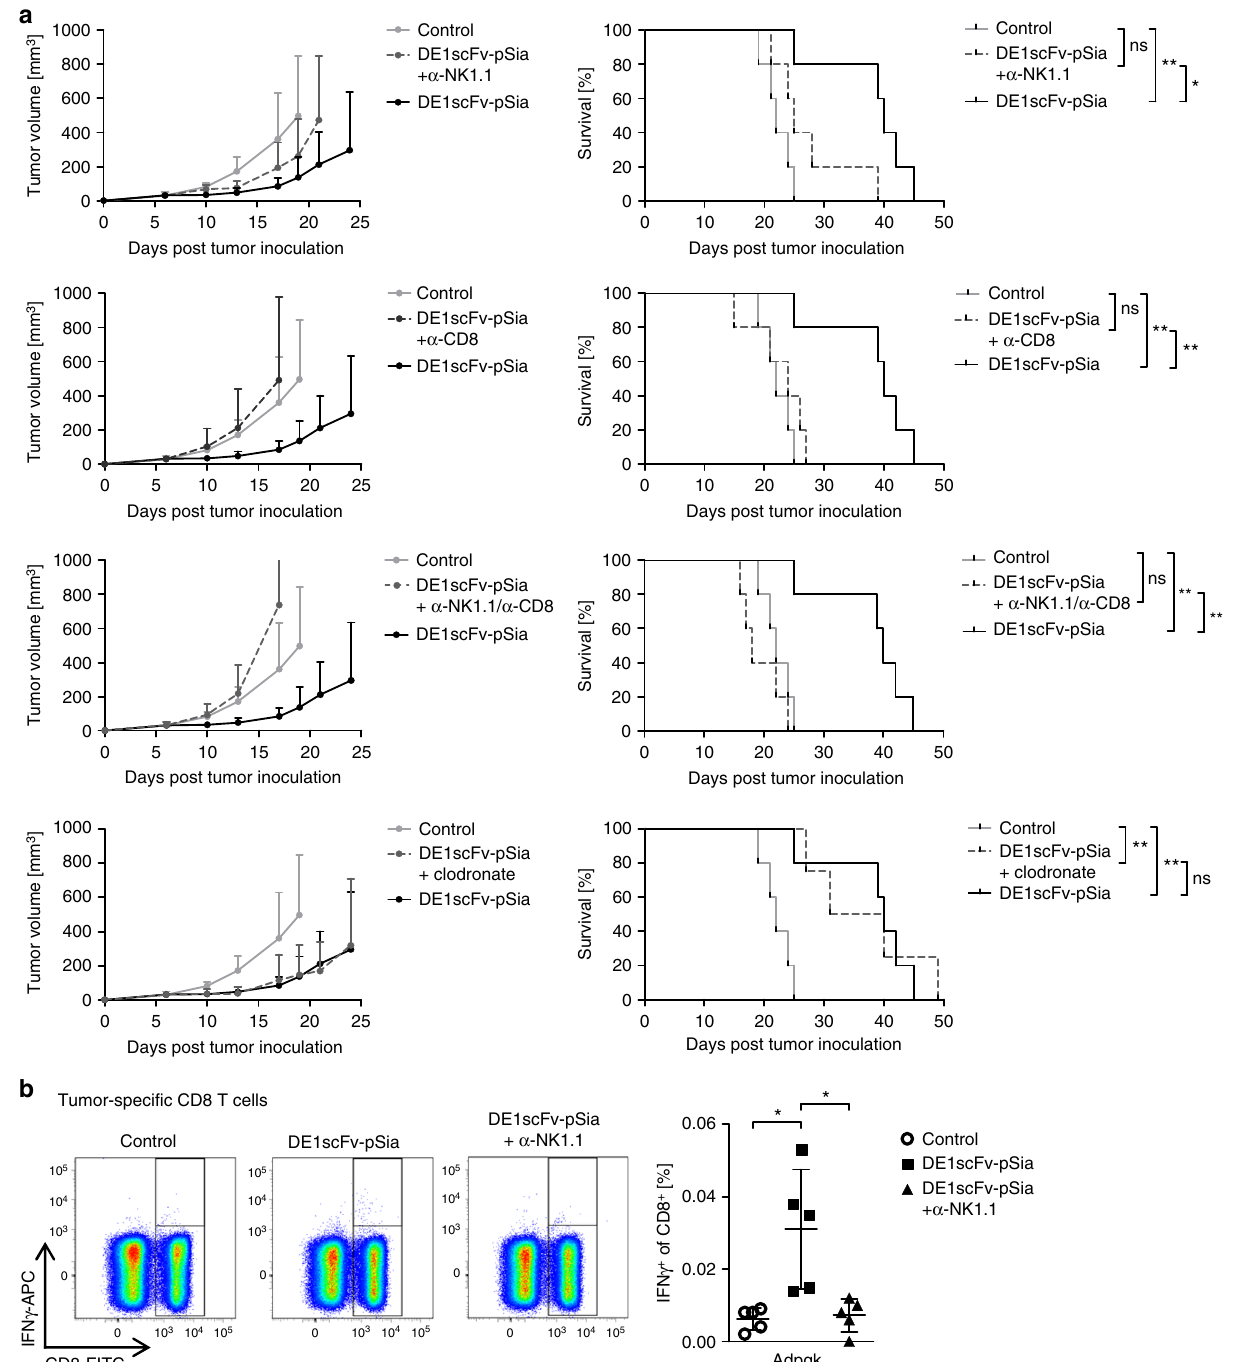
Fig. 4 The therapeutic effect of Ab-retargeting is mediated by NK cell-dependent triggering of CD8 T cells. a According to the procedure illustrated in Fig. 2a, subcutaneous MC38-pSia tumors were established in Ad5-vaccinated mice and treated with i.v. injections of DE1scFv-pSia or saline. In addition, the in fl uence of NK cells, CD8 T cells, and macrophages on treatment success was studied by depletion of the indicated immune cell subsets starting 2 days before fi rst adapter treatment using depleting antibodies α -NK1.1 and α -CD8 for depletions of NK cells and CD8 T cells, respectively, or clodronate liposomes for depletion of macrophages. Tumor development (left) and survival (right) were monitored. Group size n = 5 for all groups, except for the macrophage depleted group (DE1scFv-pSia + clodronate; n = 4); the same control and DE1scFv-pSia group without depletion agent is shown in each plot. b On day 17 after tumor inoculation, splenocytes of control and adapter-treated groups with or without NK cell depletion were prepared and examined for Adpgk-R304M-reactive tumor-speci fi c CD8 T cells ( n = 5 per group) by incubation with the corresponding peptide ASMTNMELM as described in Fig. 3f. Log-rank (Mantel – Cox) test was used to calculate survival statistics in a . Two-tailed unpaired t test was used to calculate statistics in b . * p ≤ 0.05; ** p ≤ 0.01. Error bars refer to standard deviation (SD). Source data are provided as a source data fi